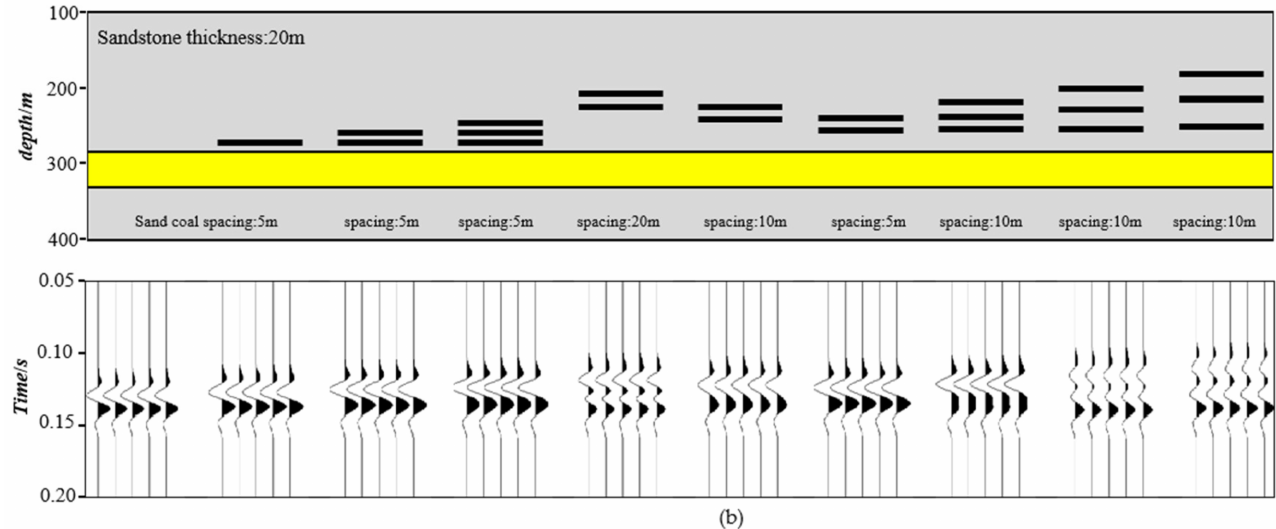
Figure 5. Forward models with coal seams and sand–coal assemblages. ( a ) Geological models with only coal seams; ( b ) geological models with both coal seams and sandstone (without coal seams, the sandstone-top surface shows trough reflection, while the sandstone–coal assemblage may show stronger or weaker amplitude and the response of sandstone cannot be recognized).